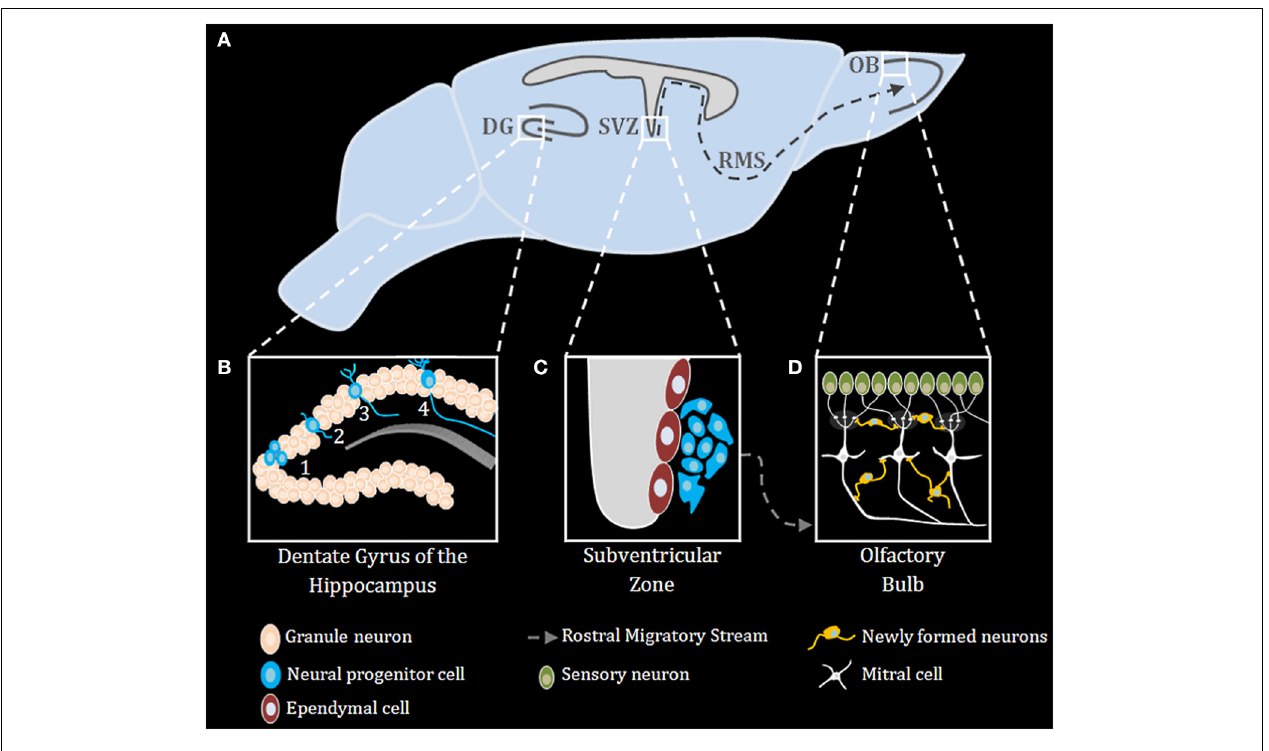
FIGURE 1 | Adult neurogenesis in the mouse brain. (A) Midsagittal view of the mouse brain with the three main regions of adult neurogenesis: dentate gyrus (DG) of the hippocampus, subventricular zone (SVZ) and the olfactory bulb (OB) (B) Adult neurogenesis in the DG of the hippocampus is generally